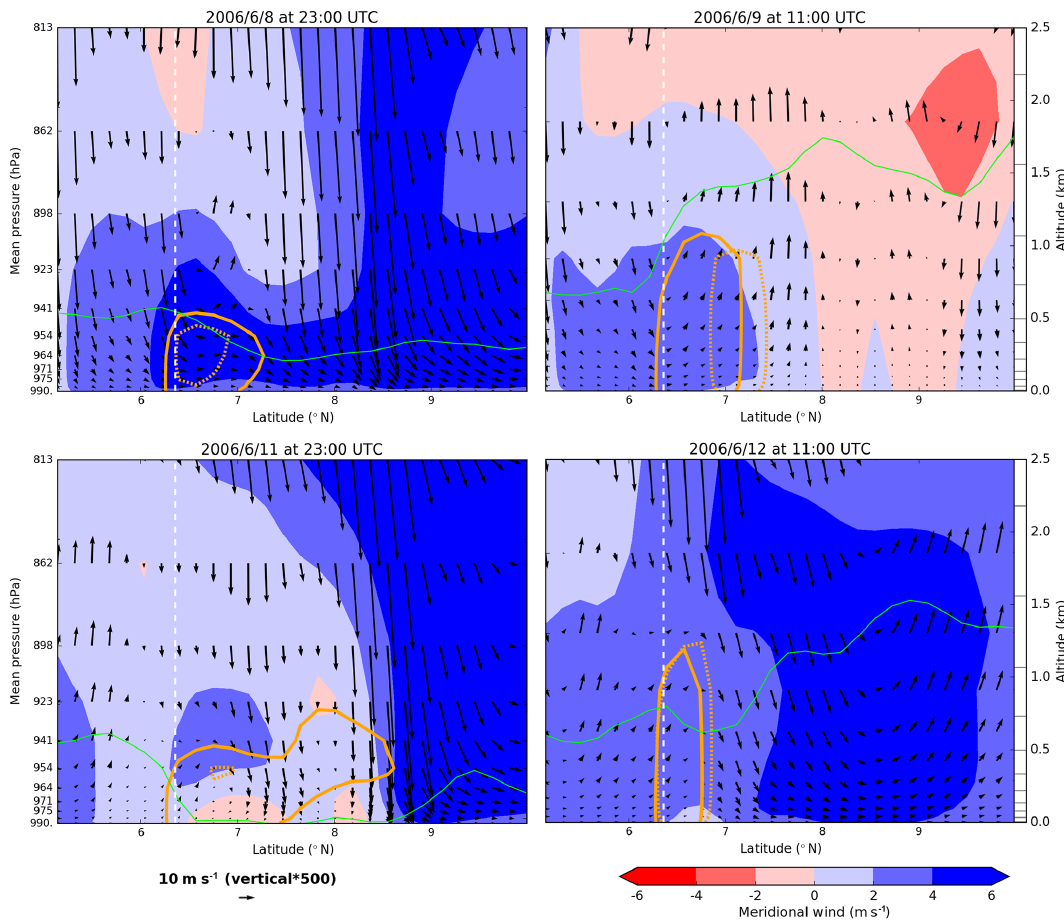
Figure 11. Vertical cross section of the meridional wind (shading in ms − 1 ) along a meridional transect from 5 to 10 ◦ N and averaged from 2 to 3 ◦ E including Cotonou (Benin). The two orange isocontours are tracer concentrations released in Cotonou and in Lome, respectively bold and dashed, with same threshold values (in arbitrary units). Vectors represent the wind field in the plan of the transect (with an aspect ratio of 500 between the meridional and the vertical components). The green line is the PBL height (m). The white vertical dash line is the latitude of the